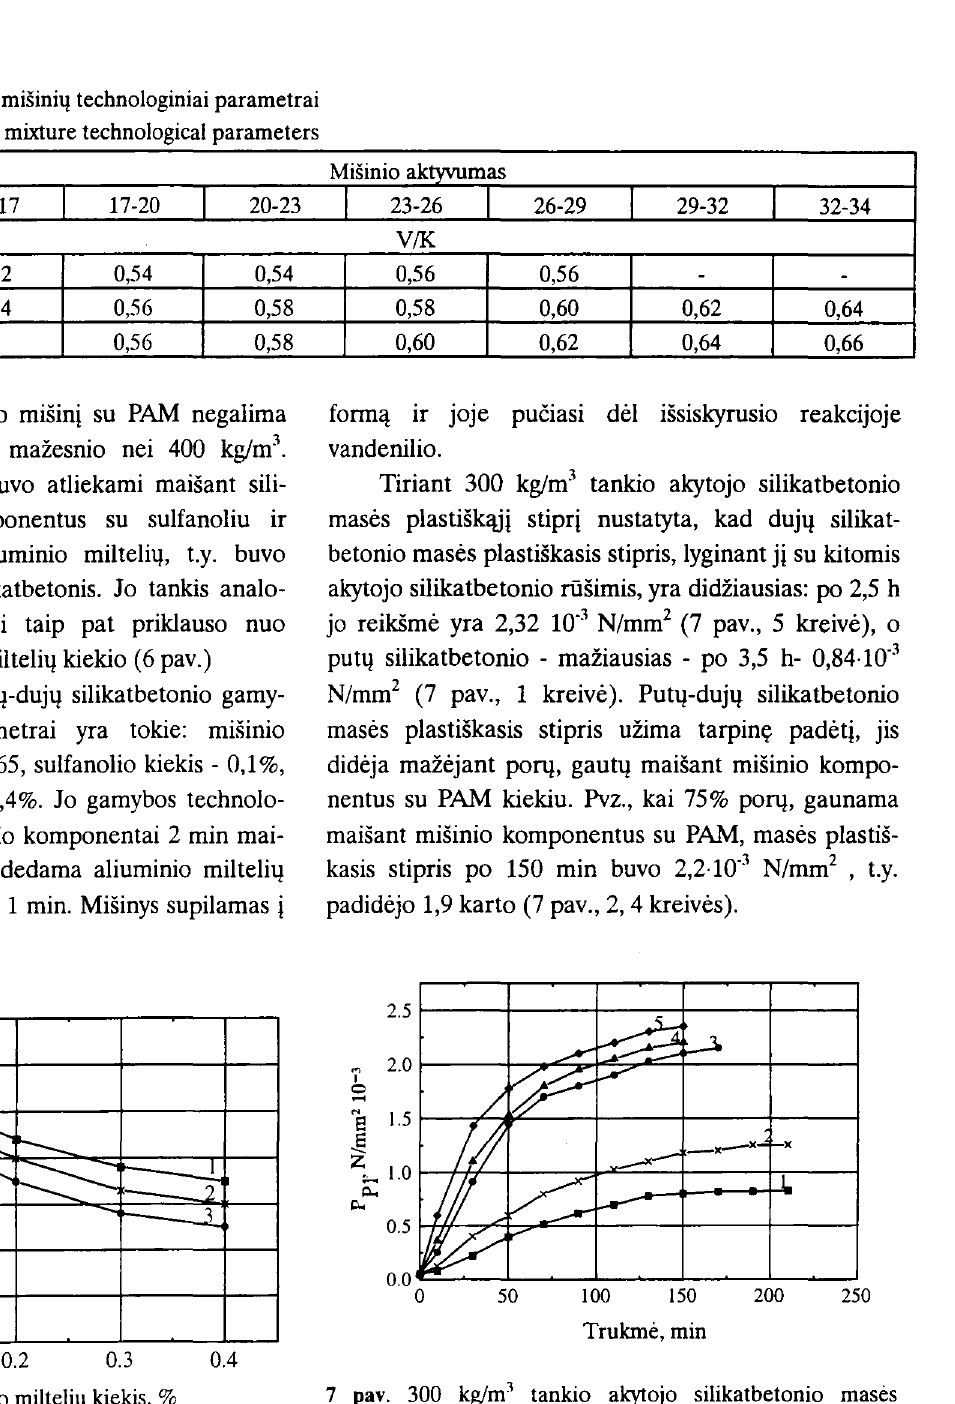
Fig 6. Foam-gaseous silicate concrete density dependency on aluminium powder amount (mixture components were mixed for 2 min, with 0,1% Sulphanol), where mixture V/S ratio: 0,6; 2- 0,65; 3- 0,7